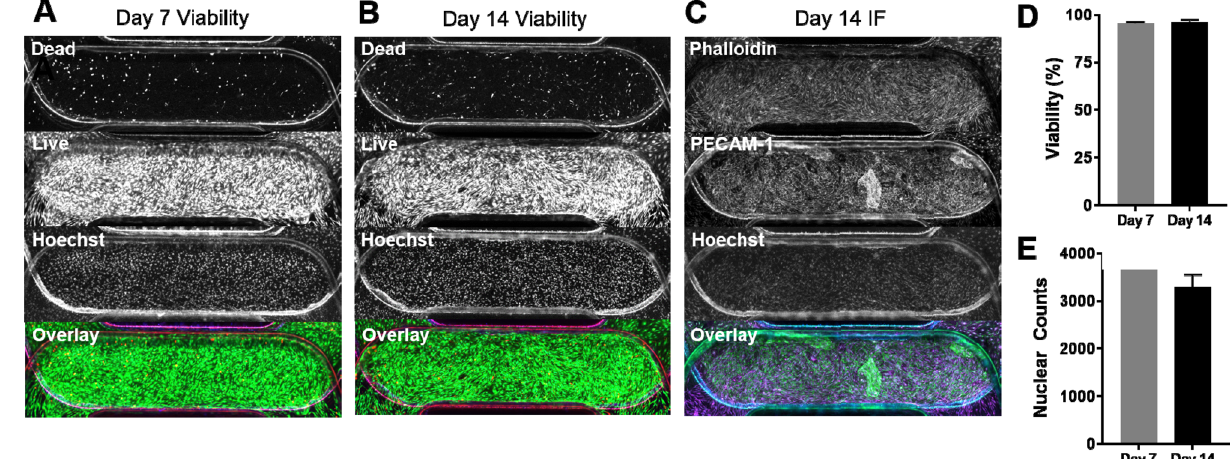
Figure 2. Long-term co-culture viability is high in PREDICT96 devices. Representative co-culture devices assessed for viability at ( A ) day 7 and ( B ) day 14 with split channels in descending order: red, green, blue, overlay. ( C ) Representative co-culture device stained for actin fibers (Phalloidin) and ECs (PECAM-1) on day 14 shows good coverage for both cell types. ( D ) Viability was greater than 95% at days 7 and 14. ( E ) Total cell numbers as determined by nuclear counts in channel overlap at day 7 and 14 did not differ significantly. N = 2 at day 7; N = 4 at day